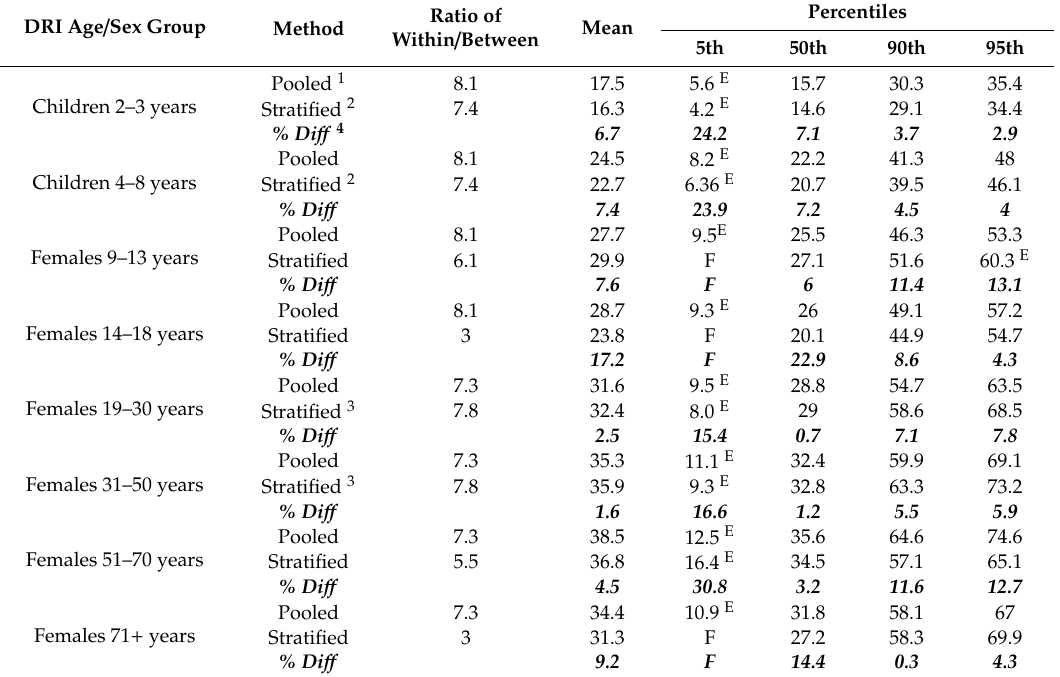
Table 2. Comparison of distributional estimates of red meats (gram) by DRI groups—NCI Method —Two Part